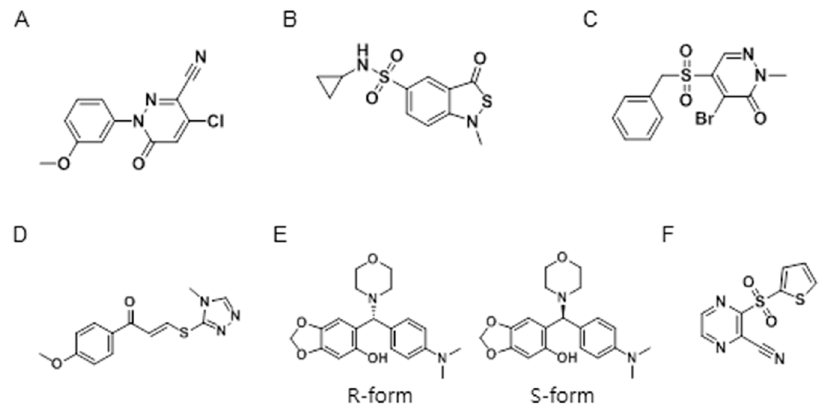
Figure 1. High-throughput screen of anti-platelet compounds. Commercially available compound libraries were screened to identify antagonists of the ADP receptor P2Y12. Six compounds were found to inhibit 20 μ M ADP-induced platelet aggregation in a 96-well format. Compounds A and C contain a pyridazinone moiety. Compounds B , D , E , and F contain sulfonamide, triazoline, morpholine, and pyrazine moieties, respectively.